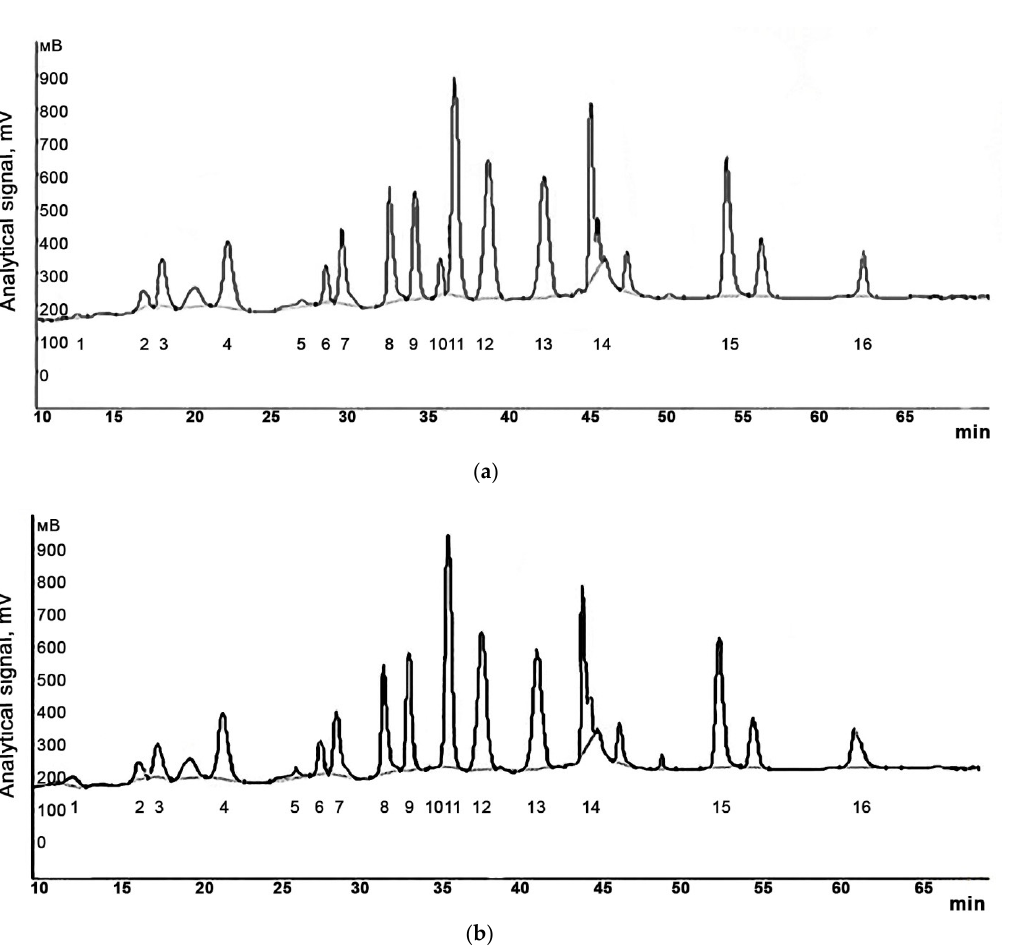
Figure 4. Results of studying the amino acid profile of the pork skin enzymatic hydrolysis products obtained using ( a ) collagenase or ( b ) Neutrase 1.5 MG: 1—isoleucine, 2—valine, 3—phenylalanine, 4—lysine, 5—histidine, 6—methionine,